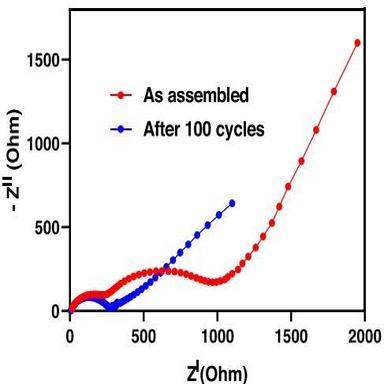
Nyquist plot of the Fe-MOF-DMF half-cell in the frequency range of 300 kHz to 1 mHz with peak to peak amplitude of 10 mV.